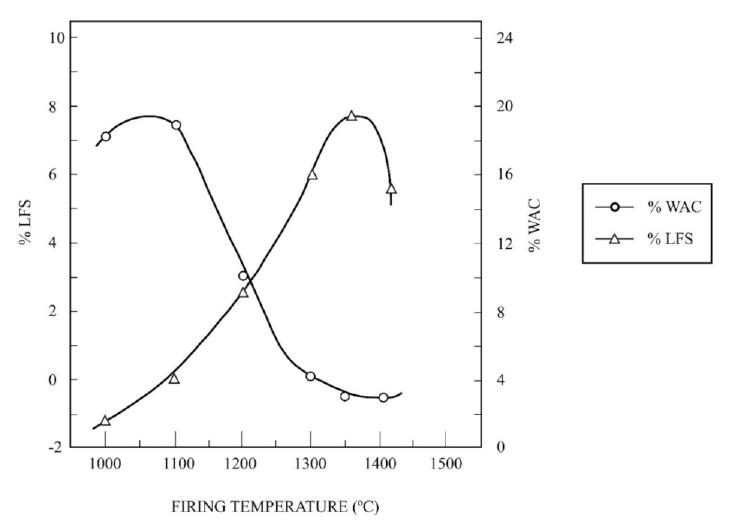
Figure 8. Thermal behaviour of the kaolin sample after grinding treatment using a hammer mill: plot of the variation of linear firing shrinkage (LFS) and water absorption capacity (WAC) as a function of firing